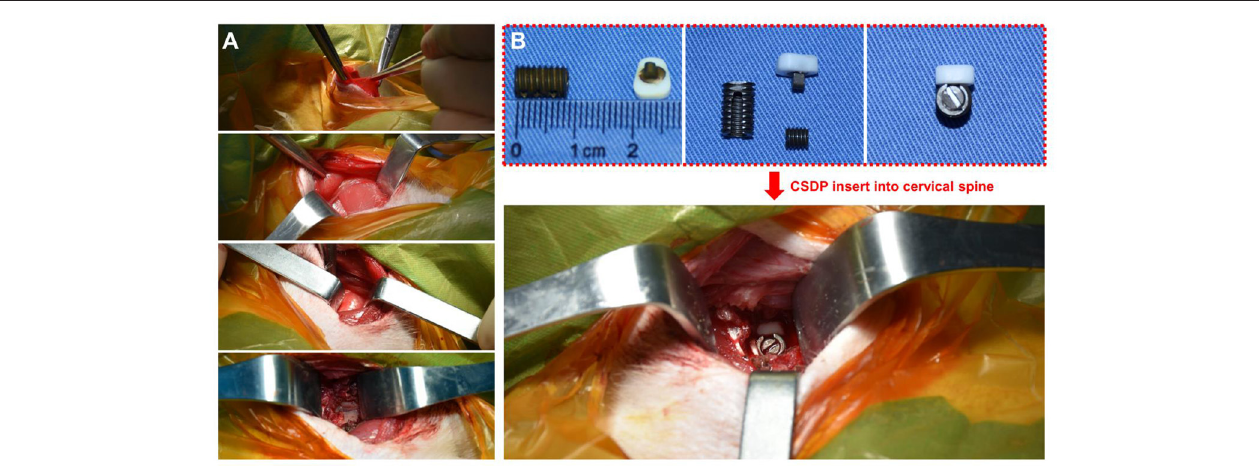
FIGURE 4 | Non-human primate cervical subtotal discectomy prosthesis (CSDP) implantation surgery. (A) After separating the skin, the platysma was cut with an electric knife. Then, the envelope fascia was sharply separated until the sternocleidomastoid muscle was seen. The sternocleidomastoid muscle was separated from the scapulohyoid muscle. Finally, the vertebral body was exposed by peeling off the longuscolli. (B) The size of the CSDP was modified based on the cervical spine anatomy of the non-human primates before implantation.